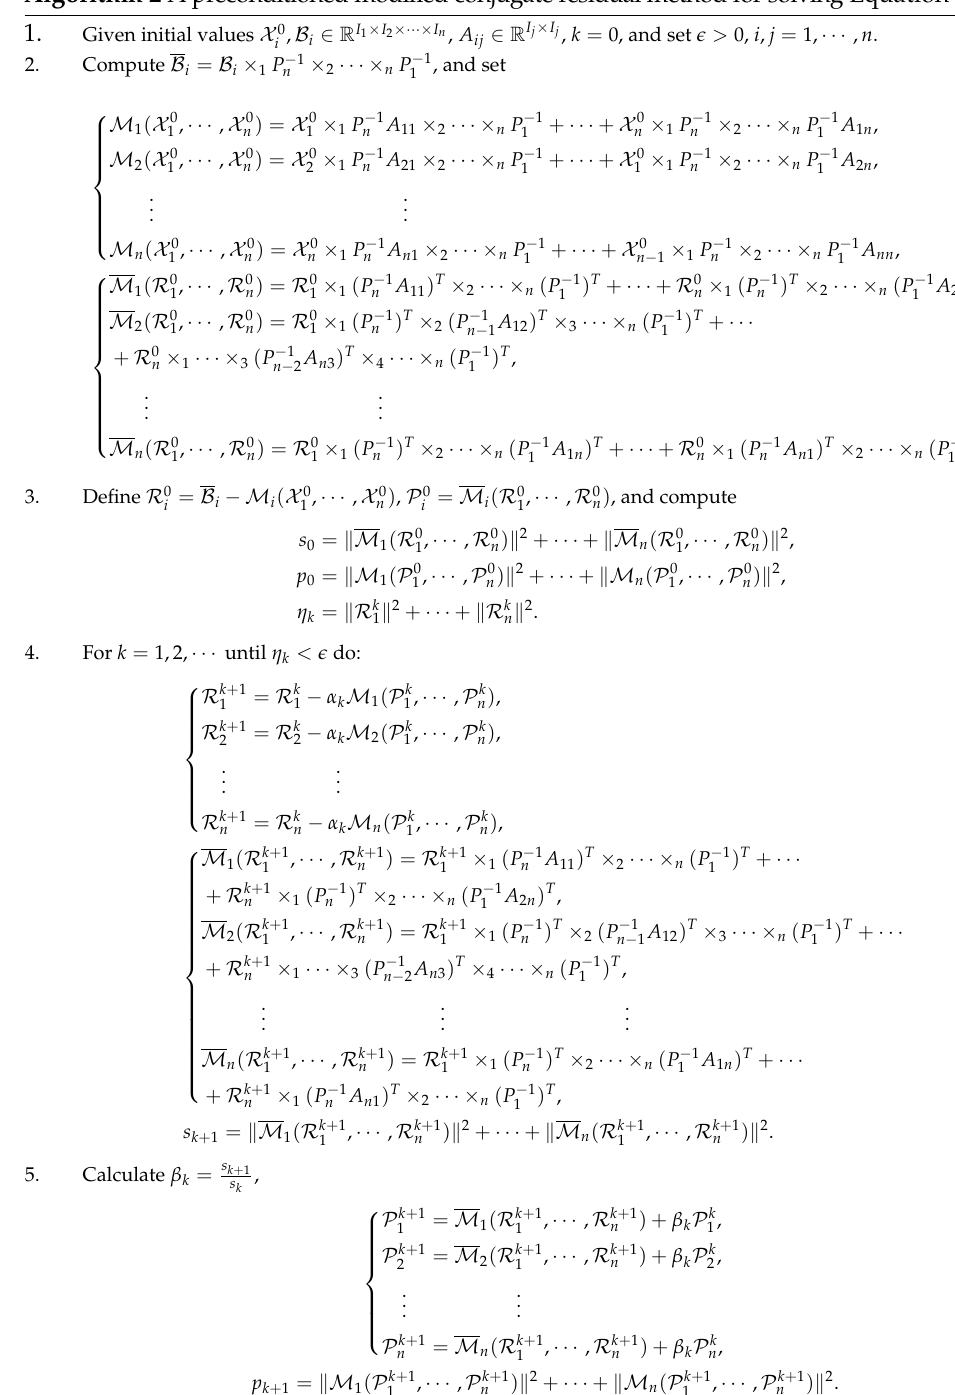
Algorithm 2 A preconditioned modified conjugate residual method for solving Equation